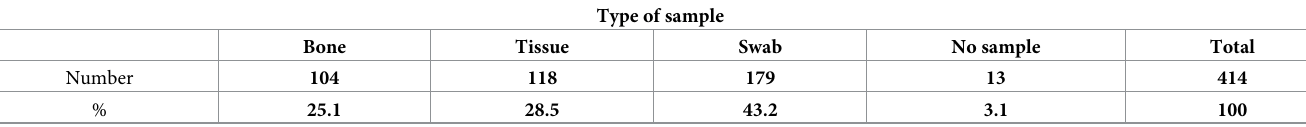
Table 1. Type of microbiology sample for diagnosis of diabetic foot osteomyelitis.